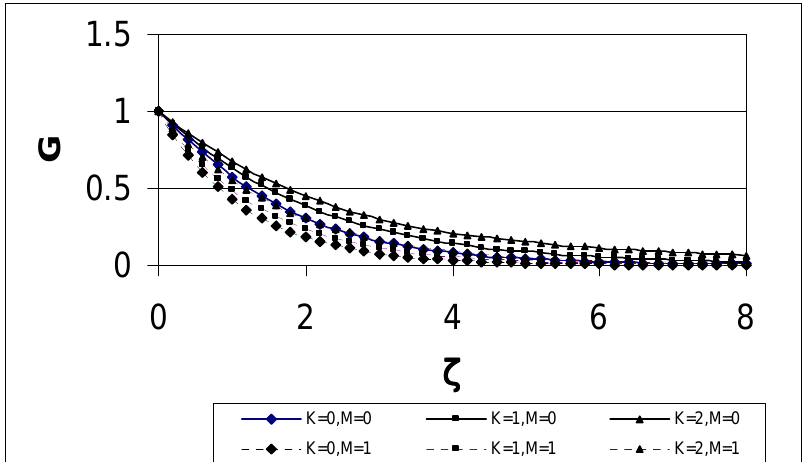
Fig. 3. Effect of the porosity parameter M and the non-Newtonian parameter K on the profile of